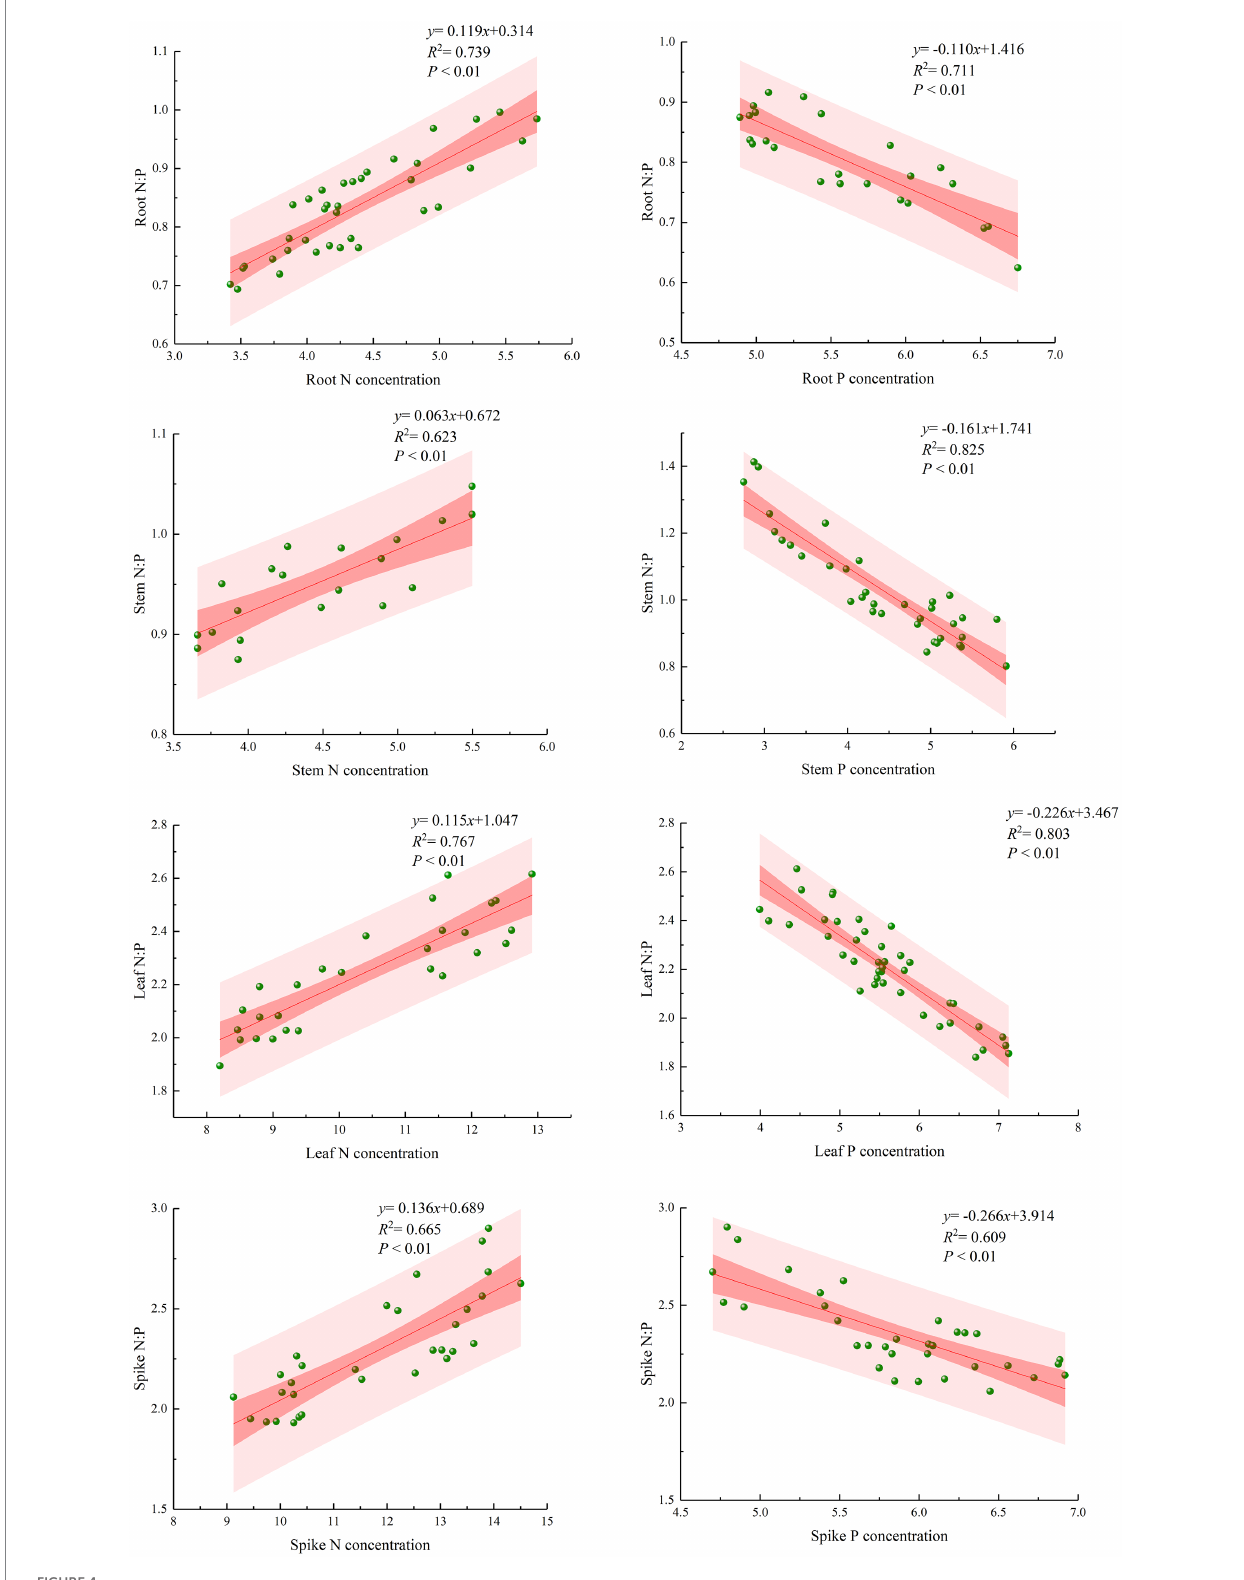
FIGURE 4 Scatter plots and best-fit lines of N/P ratio and N and P contents in different organs of